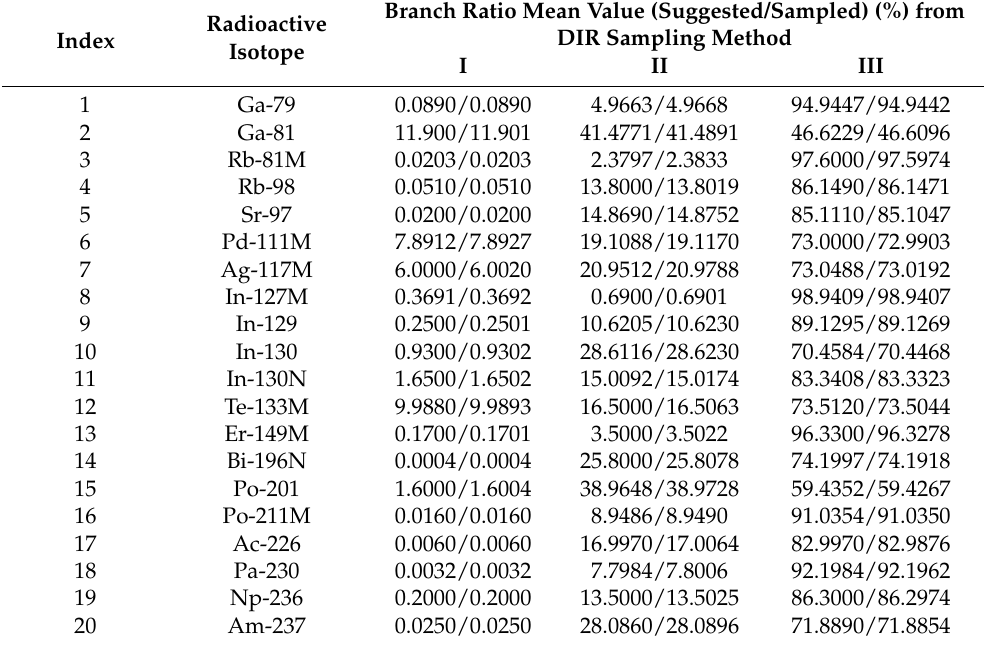
Table A2. DIR sampling: branch ratio mean value estimation results.